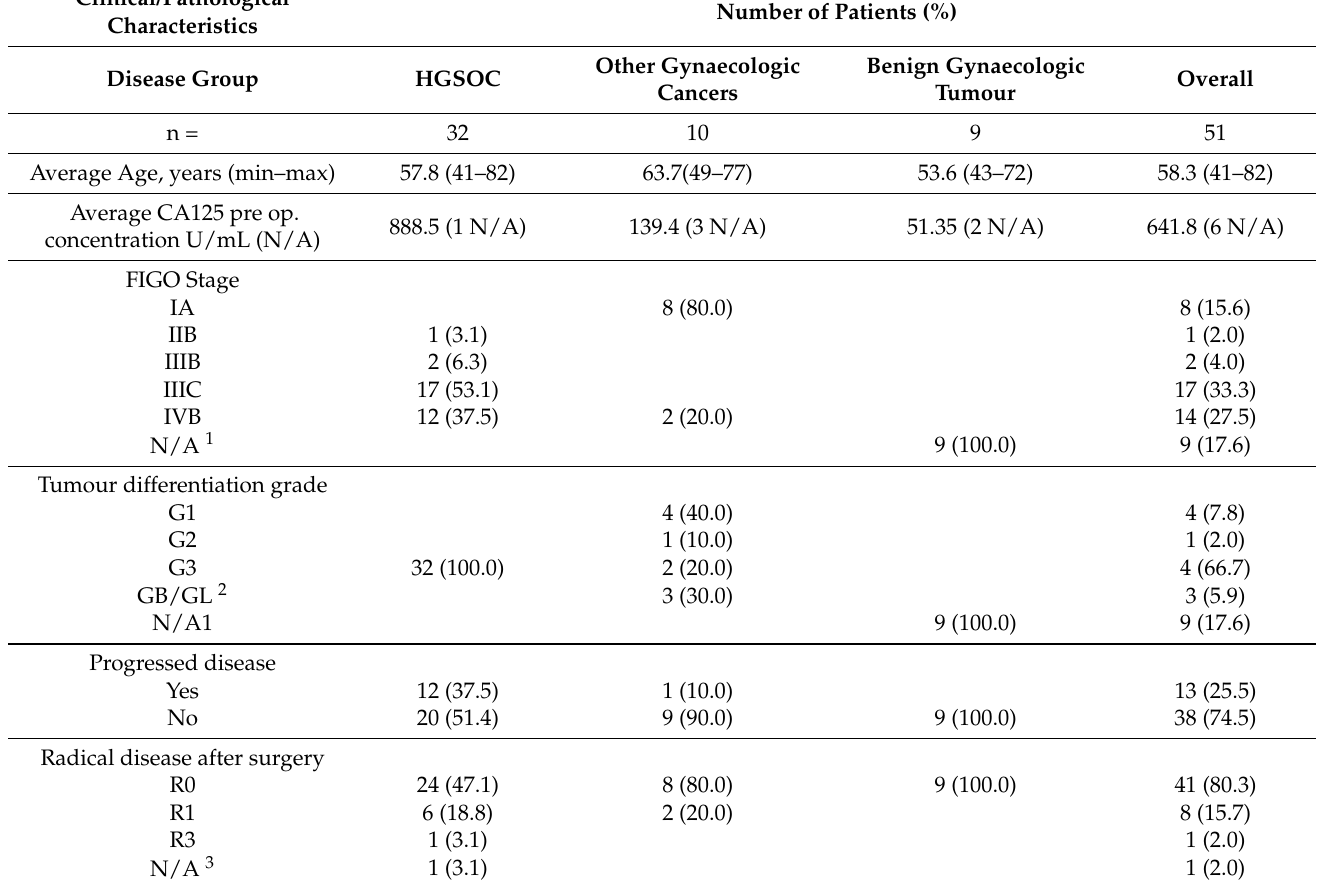
Table 2. Clinical features of the patients with tissue